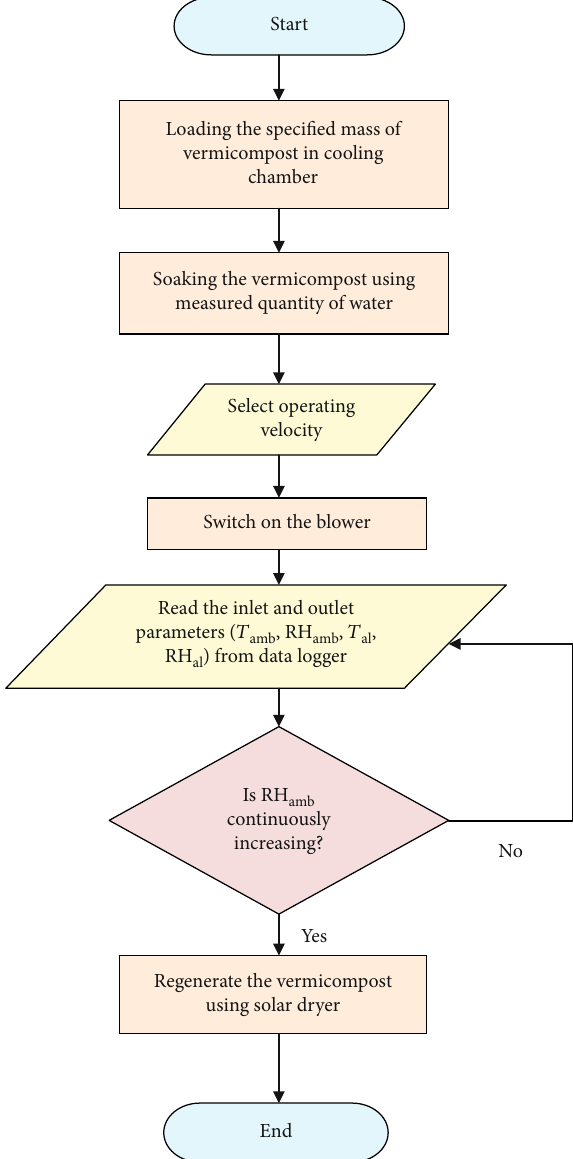
Figure 6: Flowchart of the methodology of the experimental